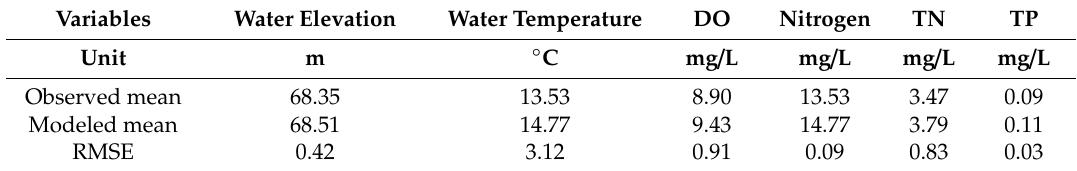
Table 2. Root mean square error (RMSE) for simulated vs. observed water quality variables of LAKE2K model. Variables Water Elevation Water Temperature